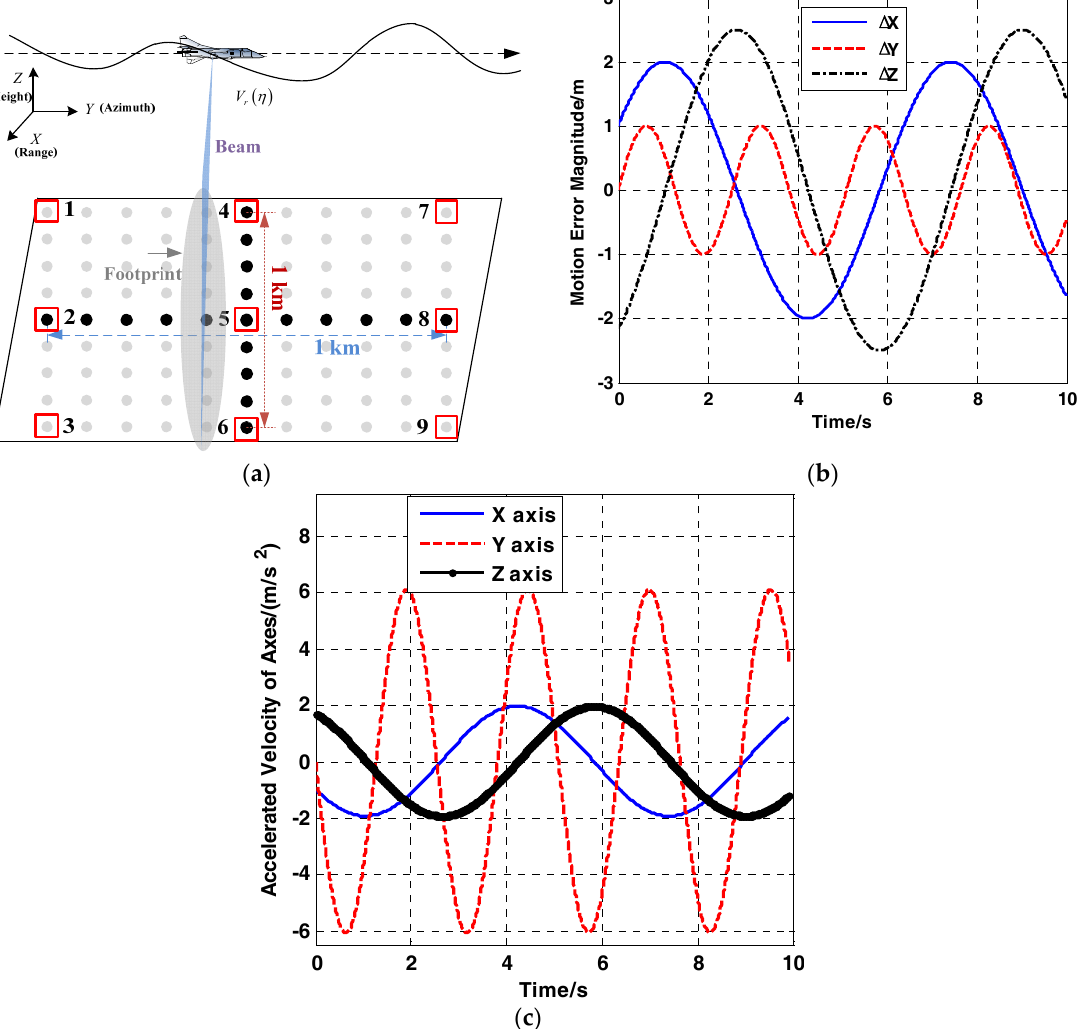
Figure 4. ( a ) Airborne SAR geometry with motion error and scene with target dots. ( b ) Error of intensive accelerated motion. ( c ) INS output.